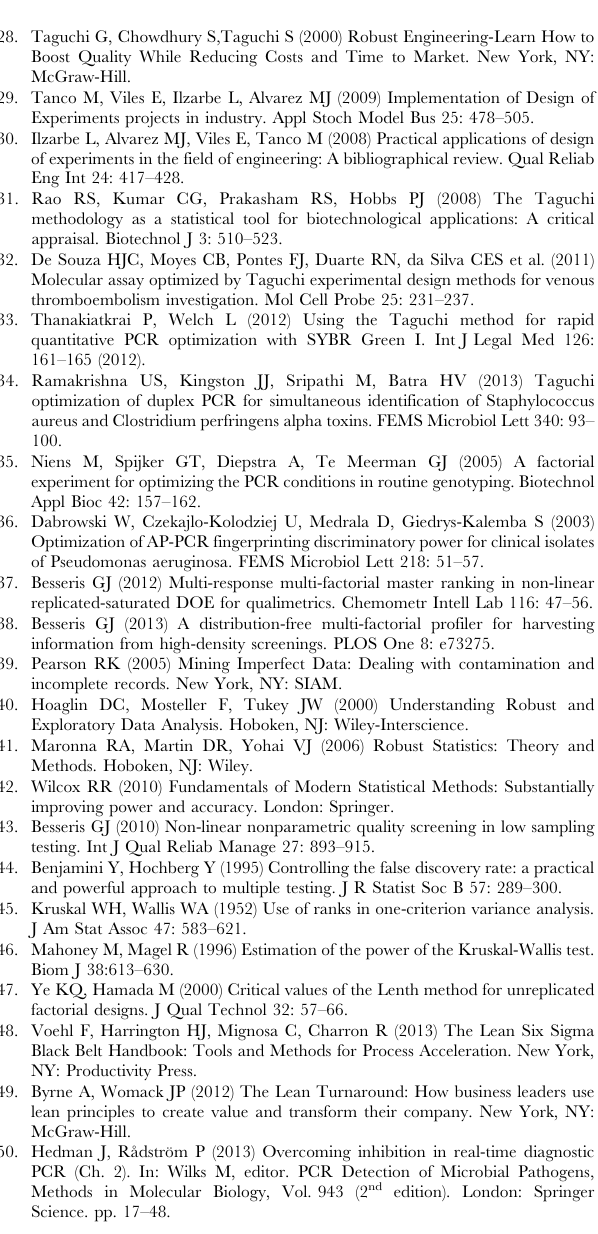
Figure S1 The main effects plot for the PCR data of epidemiological typing of Pseudomonas aeruginosa from Table S1 (MINITAB 16.2).